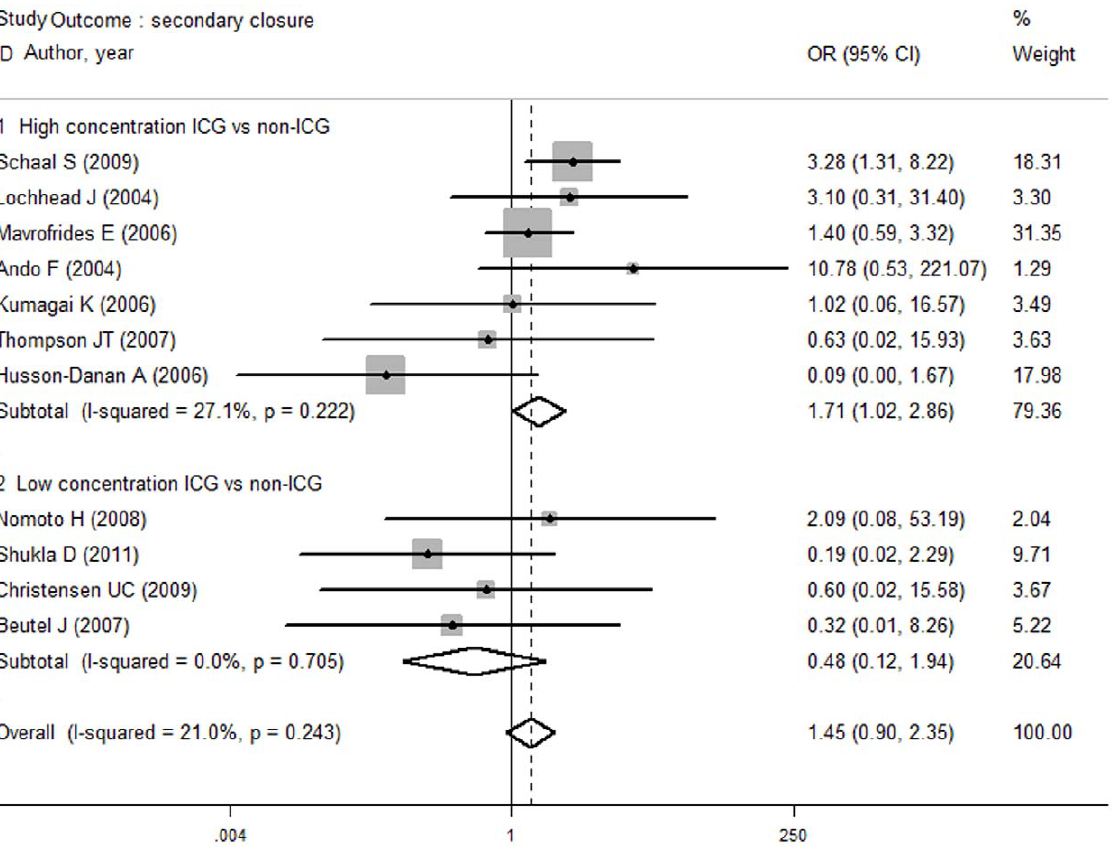
Figure 3. Subgroup analysis rate of secondary closure high and low concentration of ICG versus non-ICG group. Better secondary closure rate was detected in high concentration ICG compared with non-ICG group, while no difference was observed in low concentration ICG compared with non-ICG group.